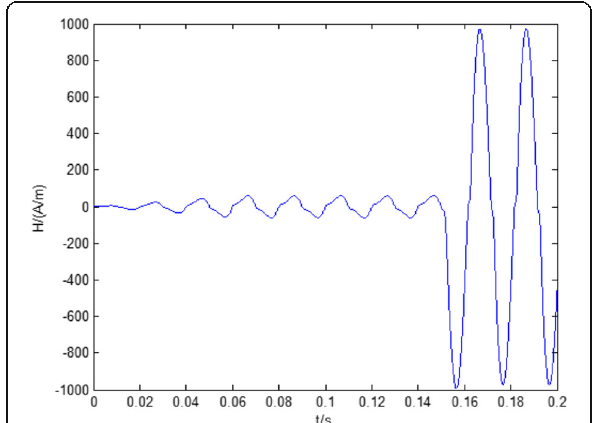
Fig. 7 Waveform of applied magnetic field strength on closed-core CT model